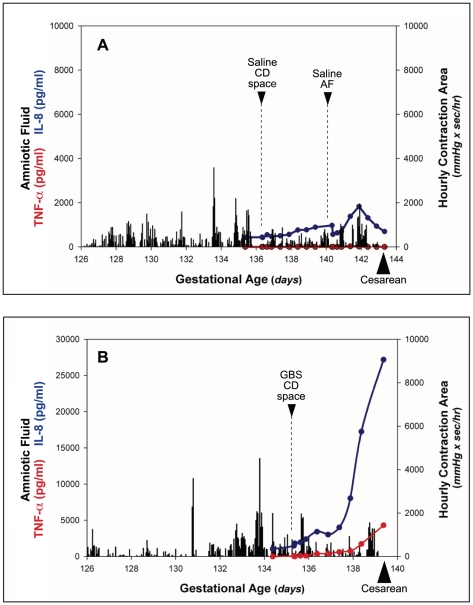
Histopathology of the fetal lungs.Hematoxylin and eosin stained histologic sections of fetal lung are shown for a saline control (A; lung score = 0) and GBS animal with severe fetal lung injury (B; lung score = 4).